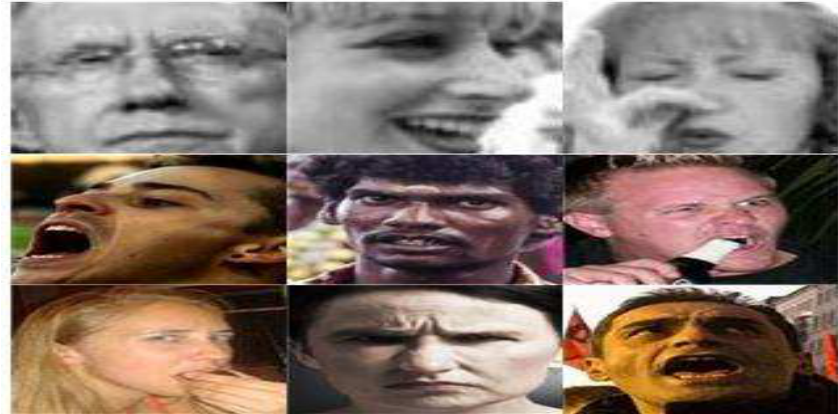
Figure 2. The samples of face detection and alignment based on Multi-task Convolutional Neural Network (MTCNN) in FER2013, Real-world Affective Faces (RAF) Basic and RAF Compound. The upper row presents samples in FER2013; the middle row presents samples in RAF Basic; the lower row presents samples in RAF Compound. Copyright reference for FER2013: https://www.kaggle. com/c/challenges-in-representation-learning-facial-expression-recognition-challenge/data; copyright reference for RAF database: